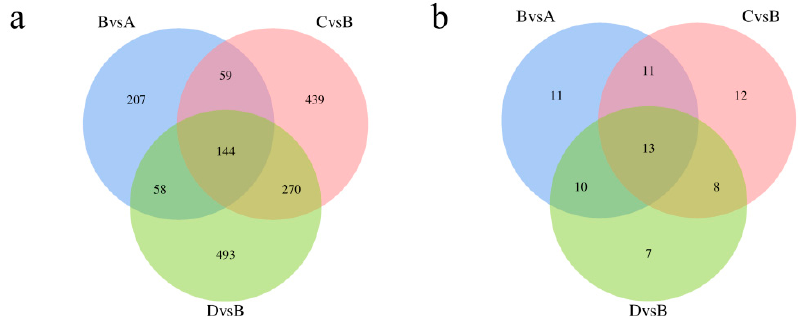
10 of 17 Figure 6. Accumulated metabolite PLS-DA and analysis of DAMs in each comparison group. ( a ) Core diagram of PLS-DA model for each comparison group in the case of positive model. ( b ) Core diagram of the PLS-DA model for each comparison group in the case of negative model. ( c ) Differ- ential number of DAMs in each comparison group. A: control group; B: treadmill group; C: acupoint catgut embedding group 1; D: acupoint catgut embedding group 2. PLS-DA: partial least-squares discriminant analysis; DAMs: differentially accumulated metabolites. We identified 11,588 metabolites. As shown in Figure 3c, 470 differentially accumu- lated metabolites (DAMs) were identified in the treadmill group versus the control group, accounting for 4.05% of the total detected metabolites. There were 920 DAMs identified between the treadmill group and catgut group 1, accounting for 7.94% of the total detected metabolites, and 972 DAMs were identified between the treadmill group and catgut group 2, accounting for 8.39% of the total detected metabolites. We then generated a Venn dia- gram to display these DAMs (Figure 6c). By visual inspection, 144 DAMs were jointly enriched in treadmill vs. control, treadmill vs. catgut 1, and treadmill vs. catgut 2 groups. Additionally, 144 DAMs were jointly enriched in treadmill vs. control and treadmill vs. catgut 1 groups. There were 59 DAMs in the treadmill vs. control and treadmill vs. catgut 2 groups and 270 DAMs in the treadmill vs. catgut 1 and treadmill vs. catgut 2 groups. KEGG pathway enrichment found a number of unique signaling pathways that dif- ferentiated the experimental groups (Figure 7a). Table 3 shows the 13 signaling pathways that were jointly enriched in the three comparison groups. Analyzing the signaling path- ways identified by transcriptomic and metabolomic analyses, we can see in Figure 7b that there are seven signaling pathways identified by both approaches; these are shown in Ta-